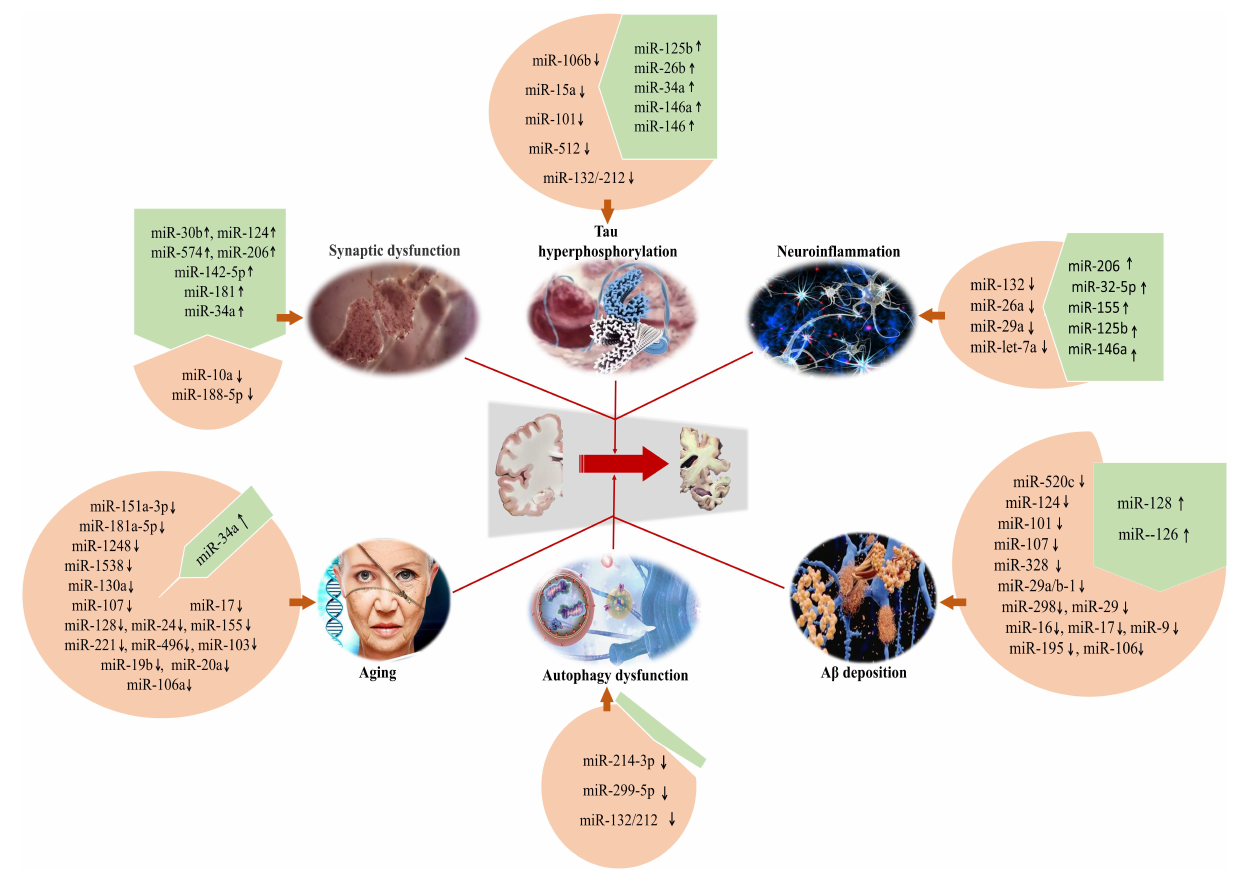
FIGURE 1 | Specific microRNAs involved in the development of AD for regulating A β deposition, Tau hyperphosphorylation, synaptic dysfunction, neuroinflammation, and autophagic dysfunction. Meanwhile, microRNAs can be considered as the preventive and therapeutic targets to develop novel and effective intervention strategies for